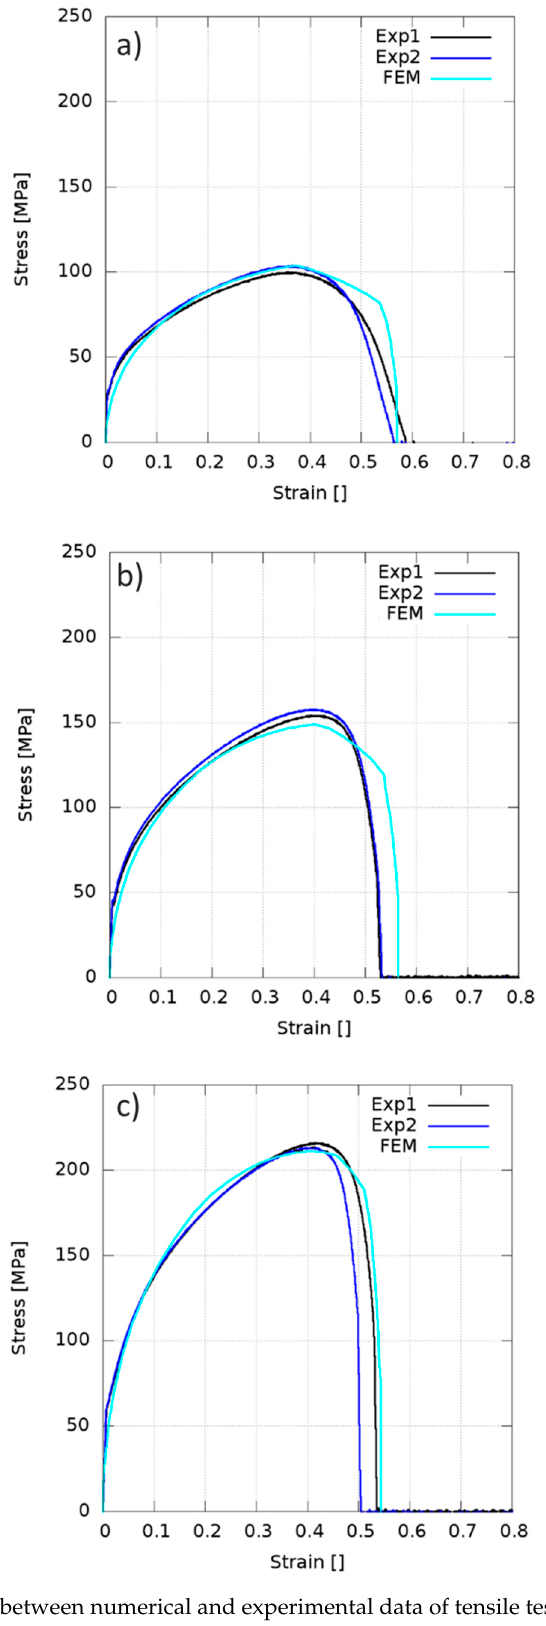
Figure 6. Comparison between numerical and experimental data of tensile tests simulation after the optimization procedure of rheological and damage coefficients. Comparisons have been reported for tensile tests carried out at: ( a ) T = 1200 °C 𝜀(cid:4662) = 5 s − 1 ; ( b ) T = 1050 °C 𝜀(cid:4662) = 5 s − 1 ; ( c ) T = 900 °C 𝜀(cid:4662) = 1 s − 1 . Once the material model has been tuned in terms of Equation (1) and Equation (4) parameters, a thermo-mechanical hot rolling 3D model has been implemented. A screenshot of the thermo-